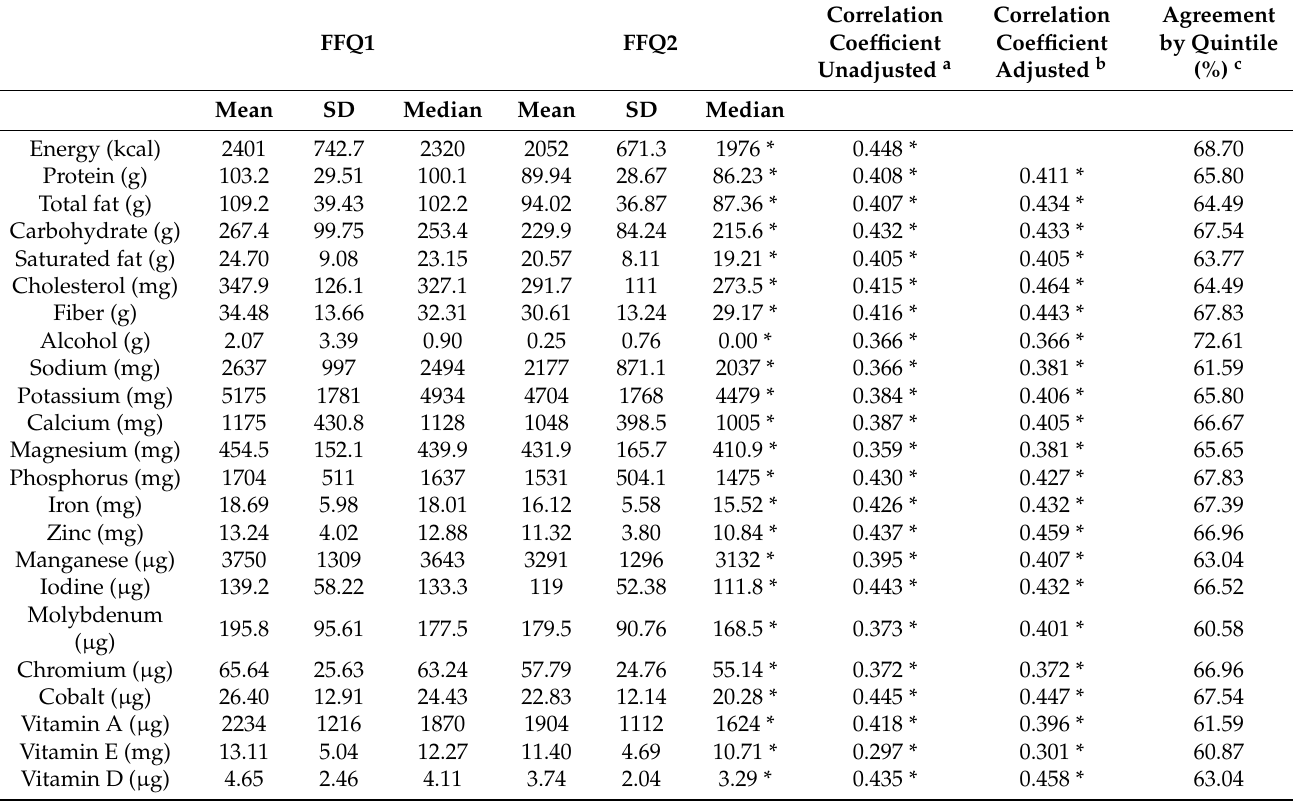
Table 3. Mean daily energy and nutrient intakes based on food-frequency questionnaires, FFQ 1 and FFQ 2 ( n =